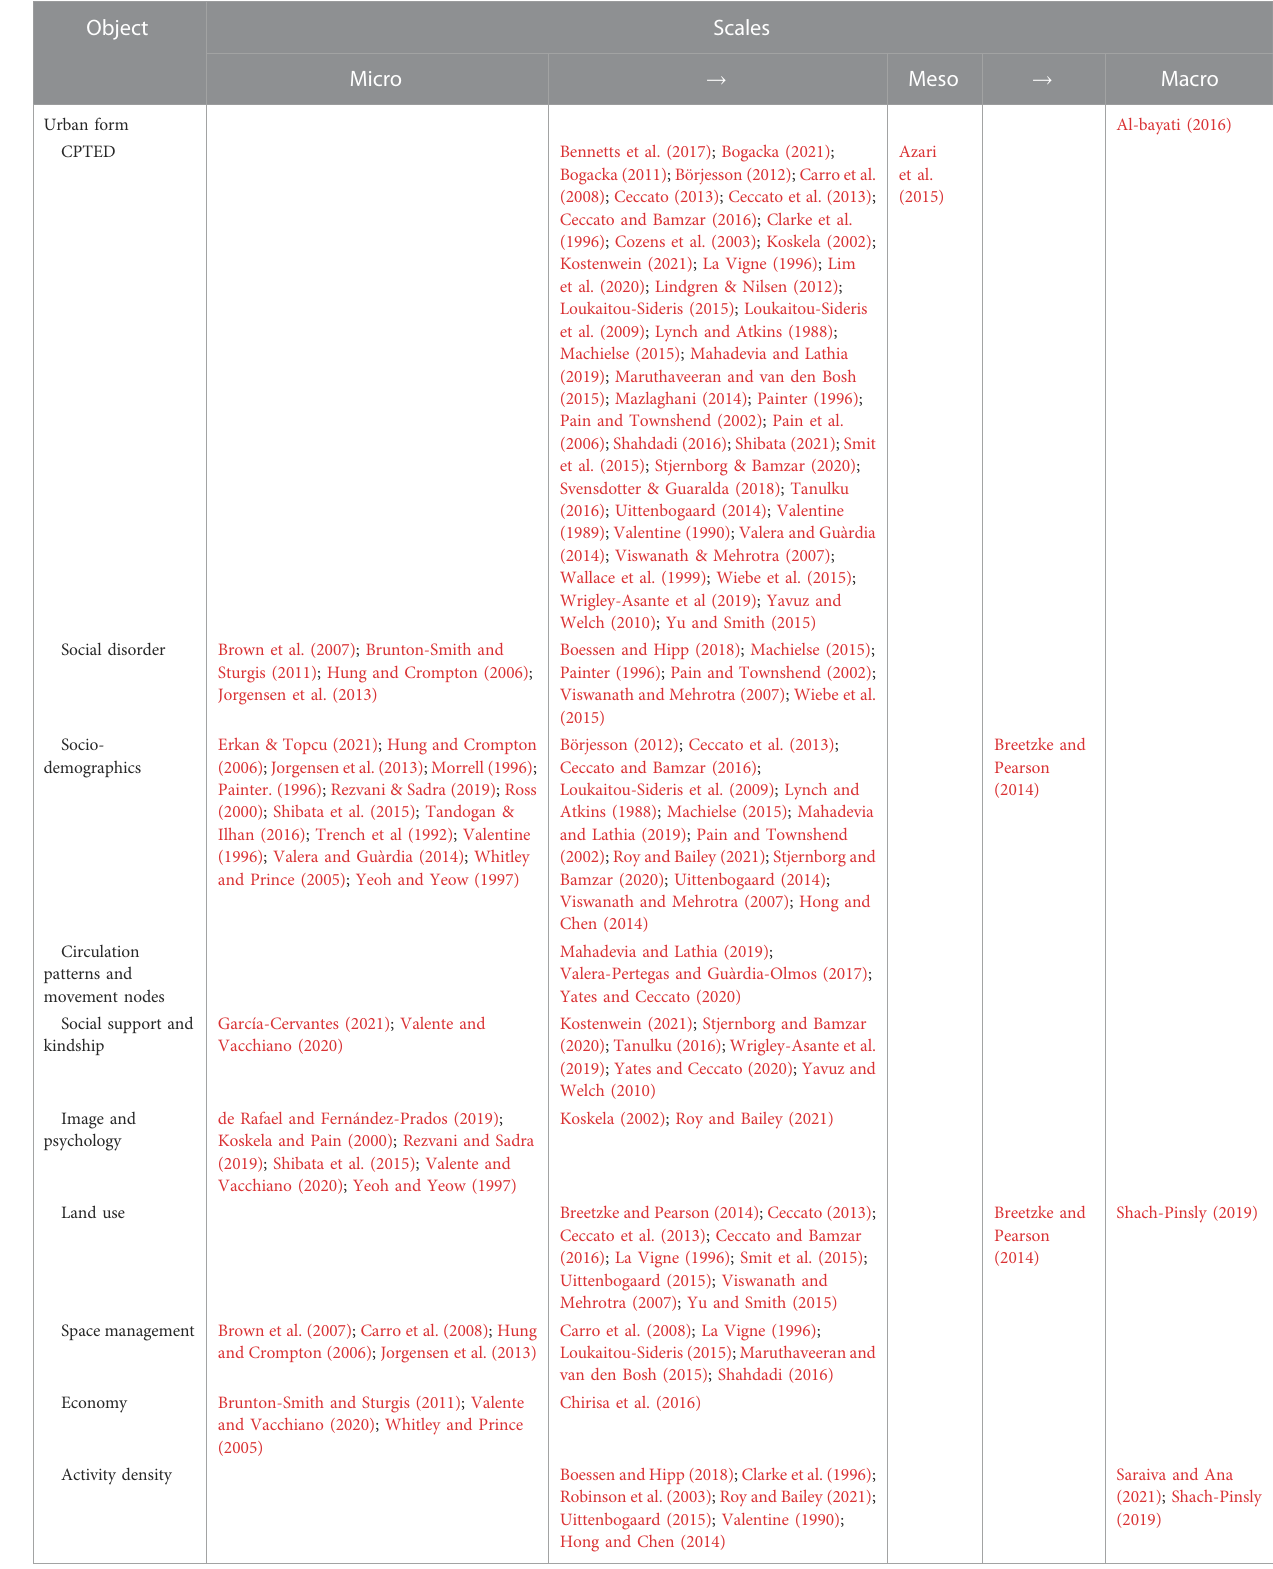
TABLE 2 Studies during 1970 – 2021 related to the object and